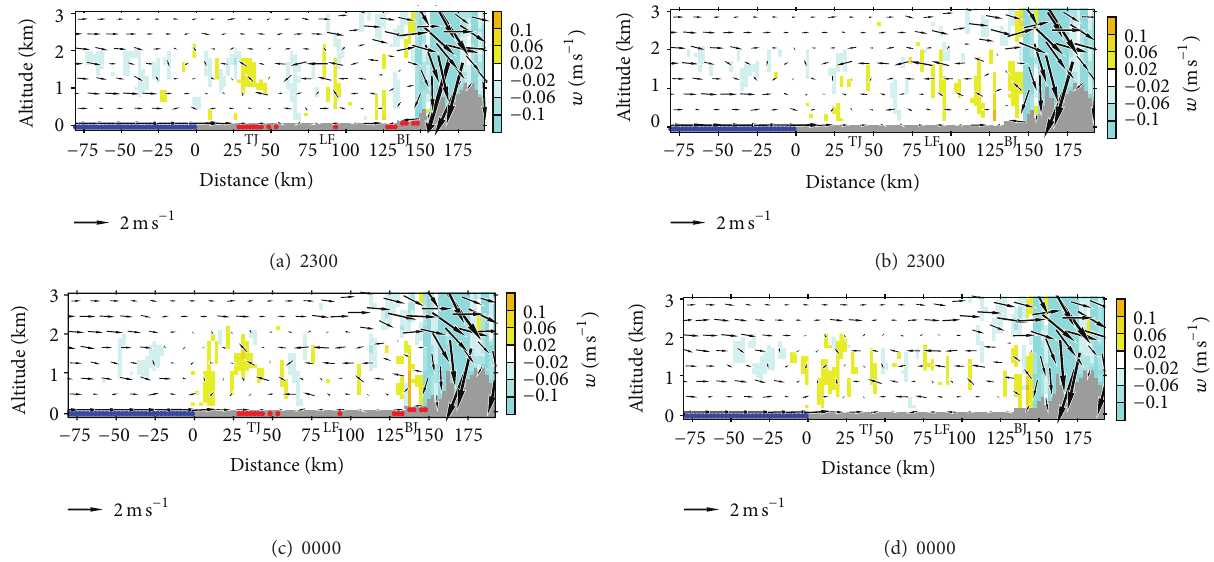
Figure 8: Similar to Figure 6, but for the vector fields at 2300 LST 24 August and 0000 LST 25 August, (a) and (c) CNTL and (b) and (d) RURAL. The three cities from left to right are Tianjin (TJ), Langfang (LF), and Beijing (BJ), respectively. Please refer to Figure 6 for more details of the figure description.